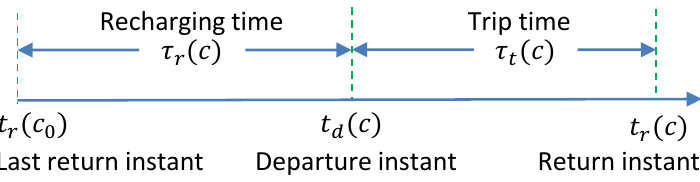
Figure 2. Illustration of key